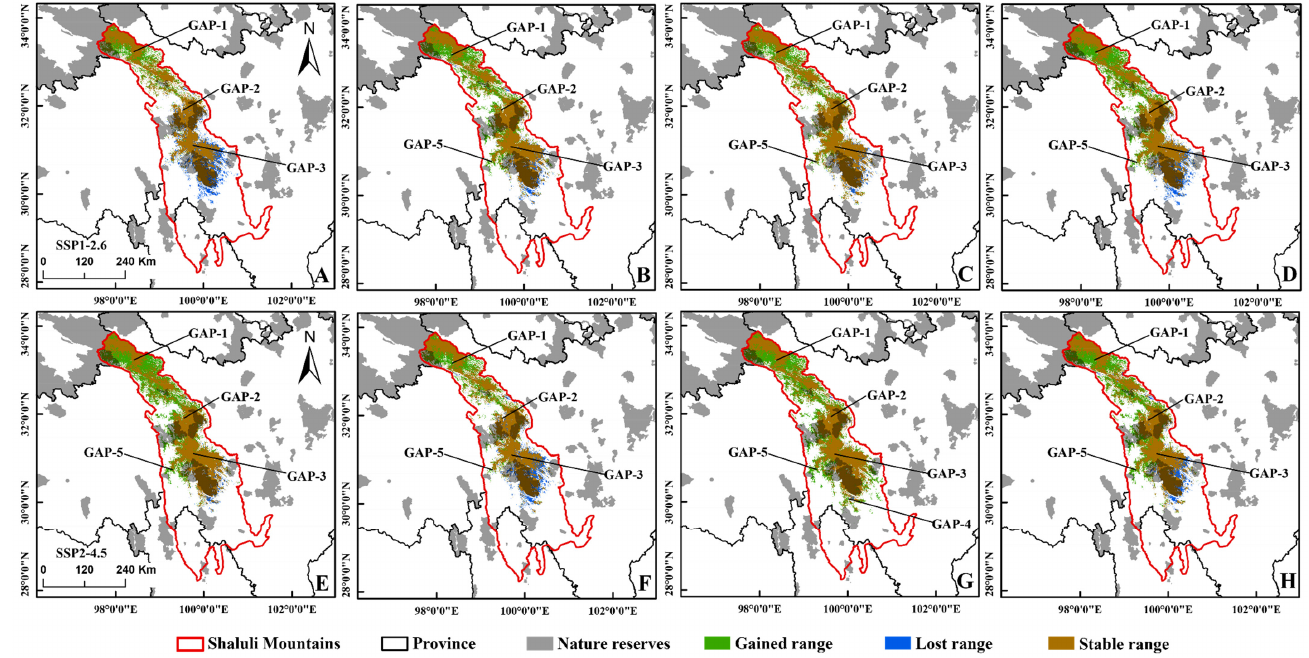
Figure 3. The potential distribution of suitable areas for the black-necked crane under the climatic conditions of shared socio-economic pathway 1–2.6 (top), 2–4.5 (bottom) during different periods of the 21st century: ( A , E ) 2021–2040, ( B , F ) 2041–2060, ( C , G ) 2061–2080, ( D , H ) 2081–2100.